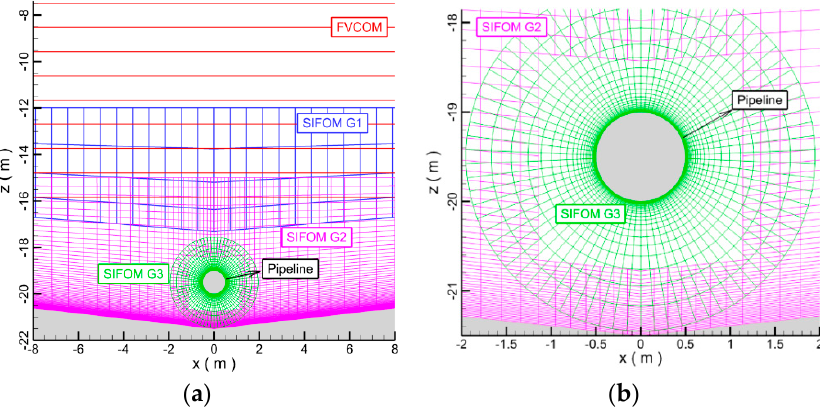
Figure 24. The meshes and scour shape of SIFOM–FVCOM. ( a ) Grids. ( b ) The mesh closing of the pipeline.